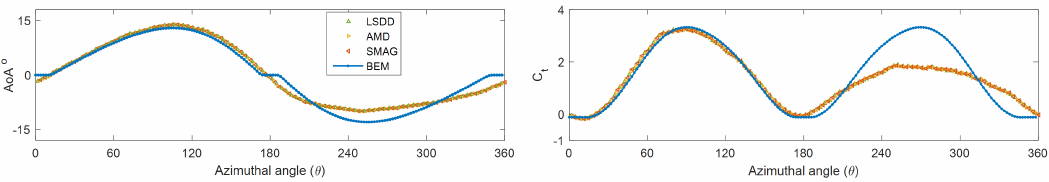
Figure 2. Mean angle of attack ( left ) and tangential force coefficient ( right ) versus the azimuthal angle, θ , for different SGS models. The azimuthal angle of the blade at the top is defined to be zero degree.